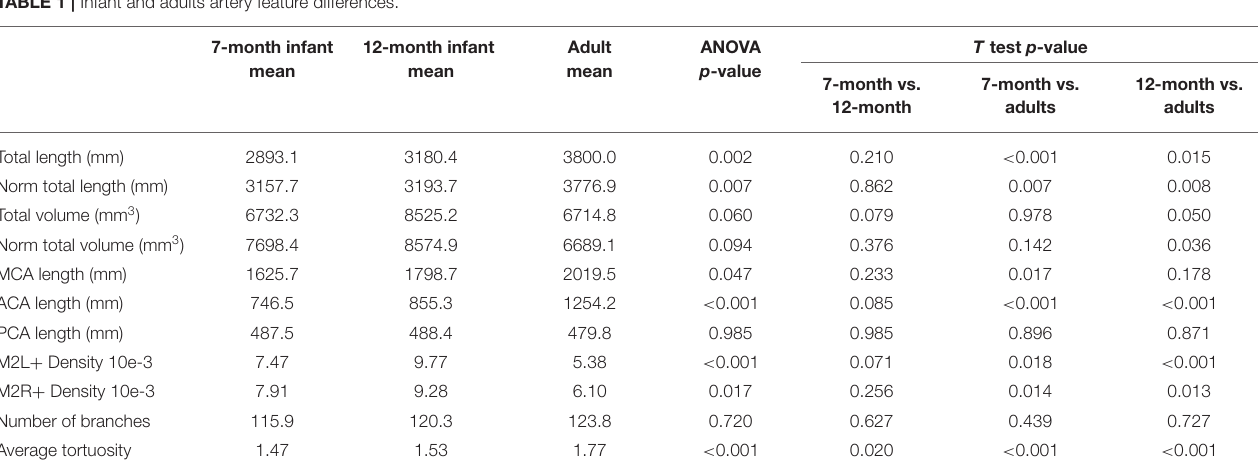
TABLE 1 | Infant and adults artery feature